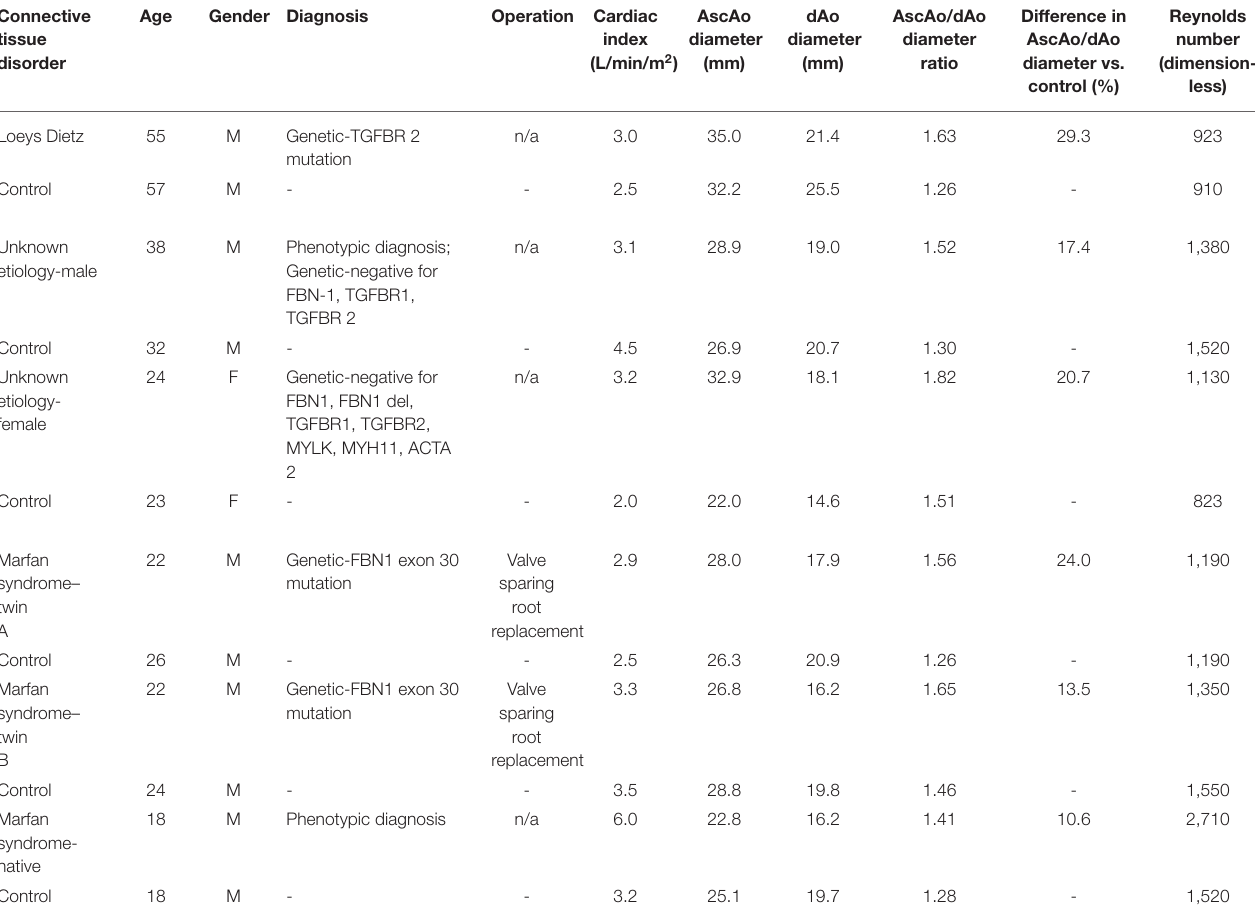
Age Gender Diagnosis Operation Cardiac